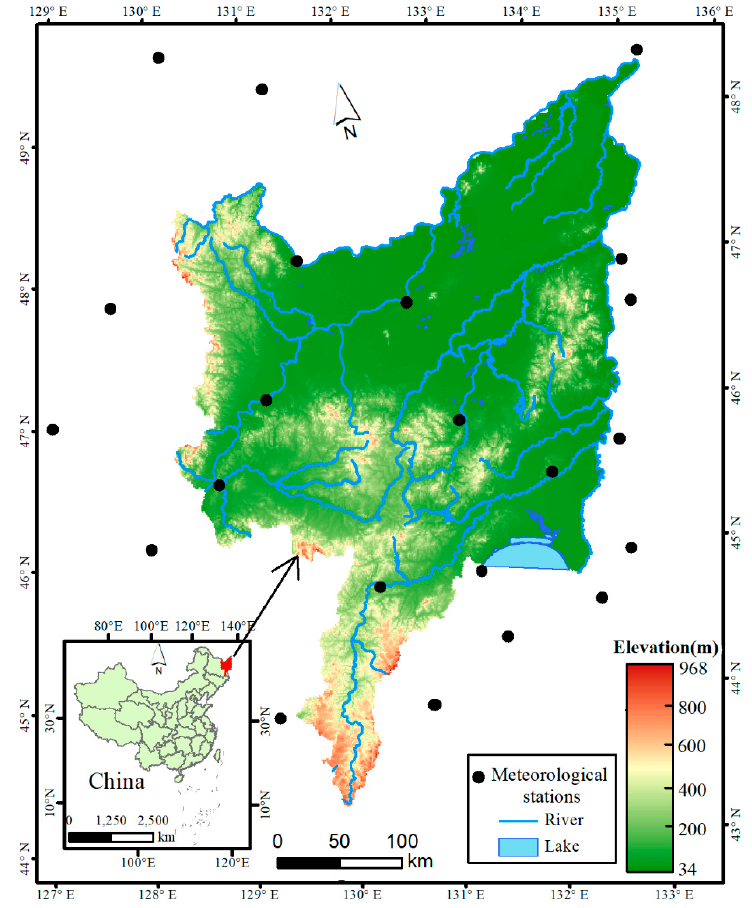
Figure 1 . Location and geographical features of the Sanjiang Plain. Figure 1. Location and geographical features of the Sanjiang